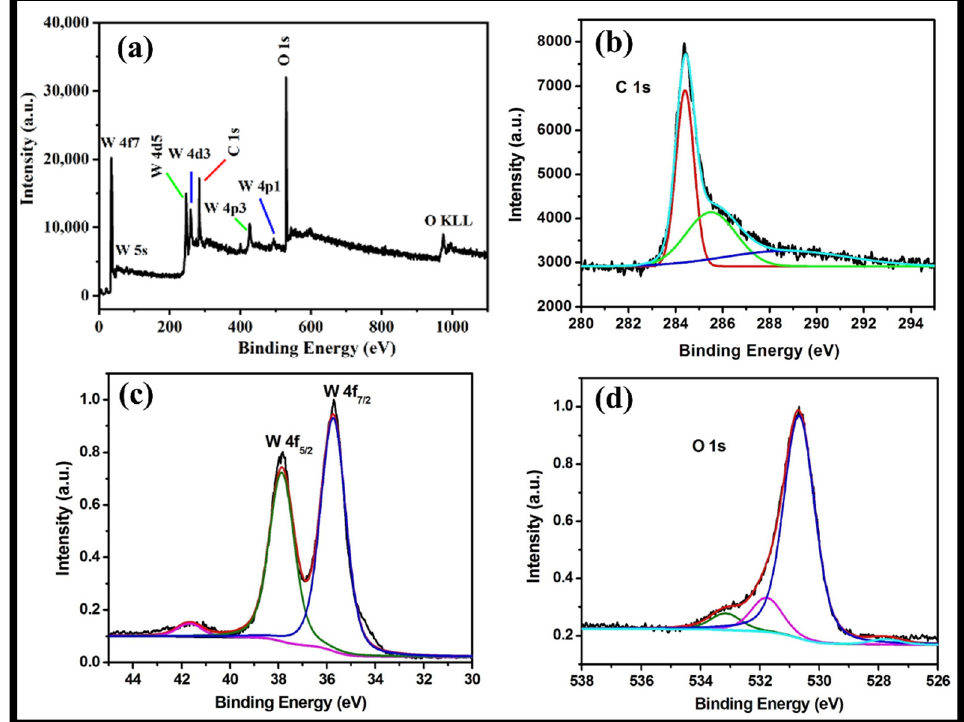
Figure 5. Typical high-resolution XPS survey of ( a ) the rGO-WO 3 heterostructure and ( b ) C, ( c ) W and ( d ) O elements.